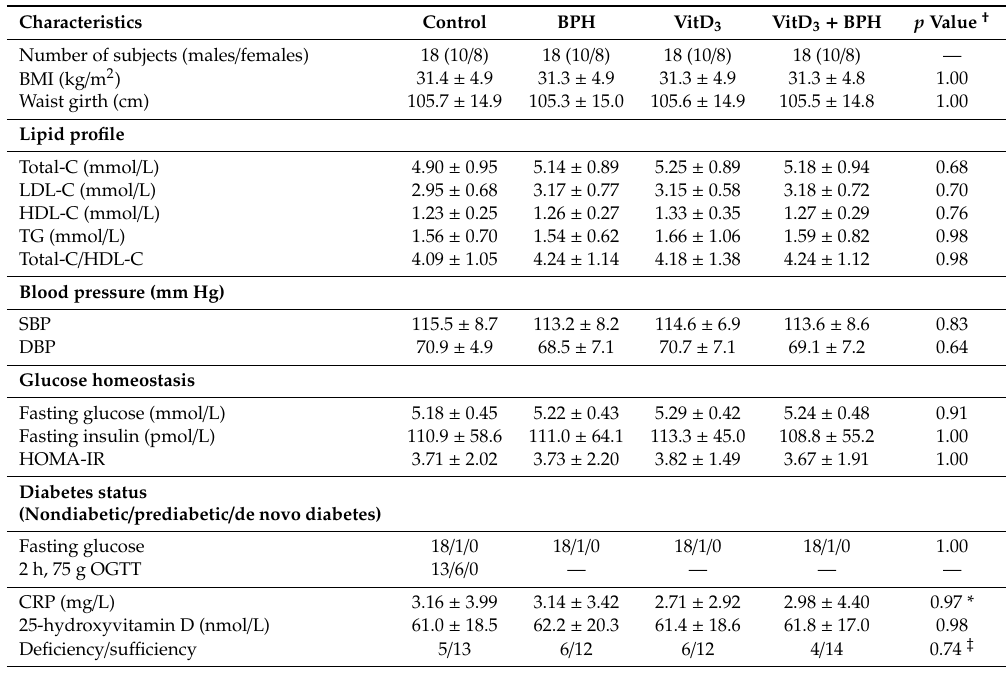
Table 3. Pre-treatment characteristics for the gene expression